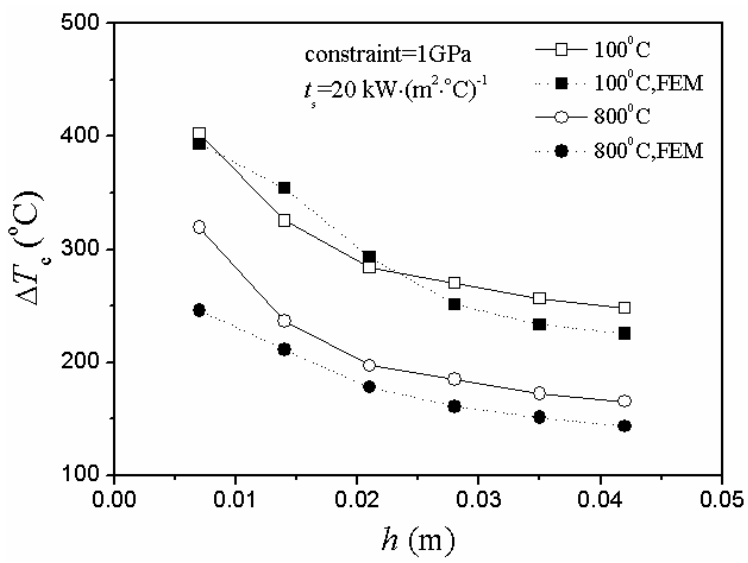
Figure 7. Relationship between critical rupture temperature difference, ∆ T thickness, h , including modified and numerical simulation situations under different initial thermal shock temperature of temperature elevated conditions.